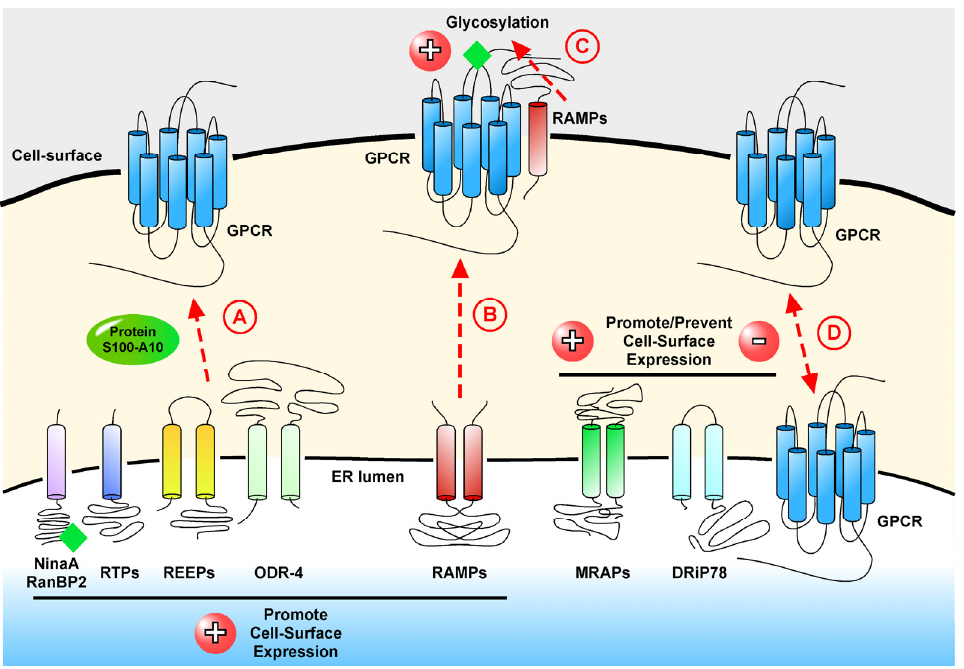
Figure 1. Schematic representation of the roles of GPCR interacting proteins in the localization of GPCRs at the cell-surface. ( A ) NinaA, RanBP2, RTPs, REEPs, ODR-4 and protein S100-A10 facilitate cell-surface localization by promoting correct folding and protein trafficking; ( B ) Receptor activity-modifying proteins (RAMPs) act as chaperones and traffic with GPCRs to the cell-surface and ( C ) promote glycosylation of the GPCR; ( D ) Melanocortin 2 receptor accessory proteins (MRAPs) and dopamine-receptor-interacting protein of 78 kDa (DRiP78) either promote or prevent cell-surface localization depending on the particular GPCR.  represents